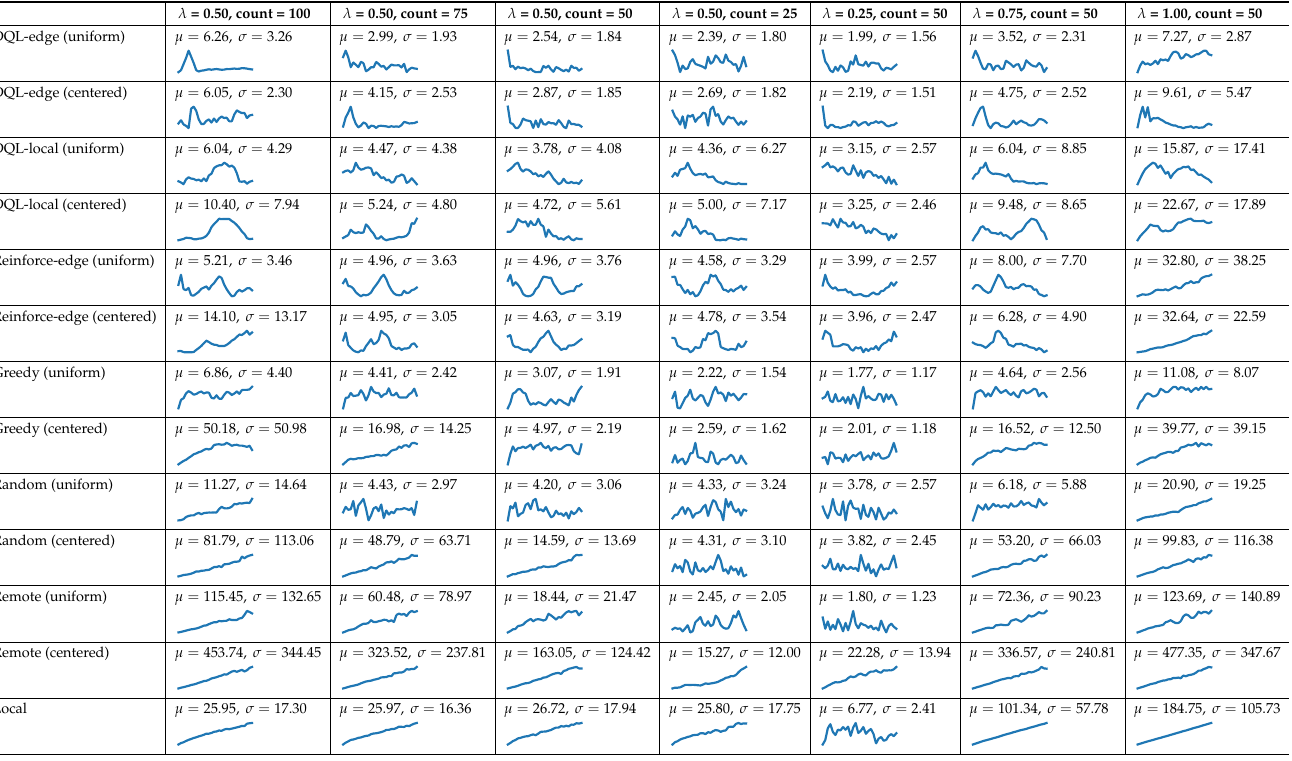
Table 2. Mean and standard deviation values of cost and the cost trend over time for different task-offloading models, mobile device location model and counts, and task arrival. rates( λ